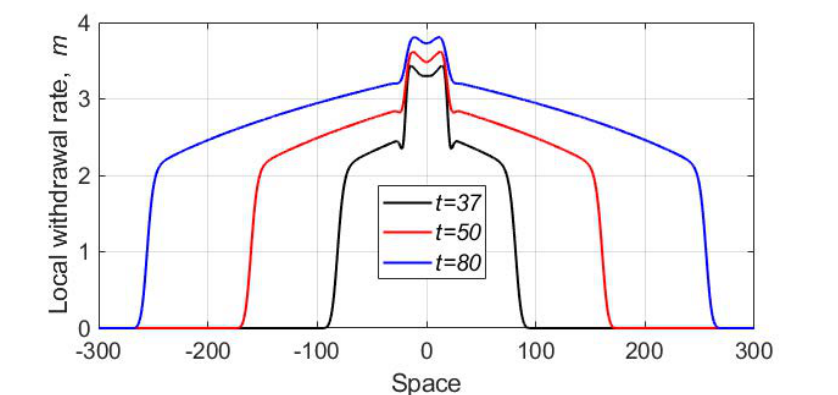
Figure 9. Distribution of the withdrawal rate over space as given by Model (12) and (13) shown at different moments of time. Parameters are the same as in Figure